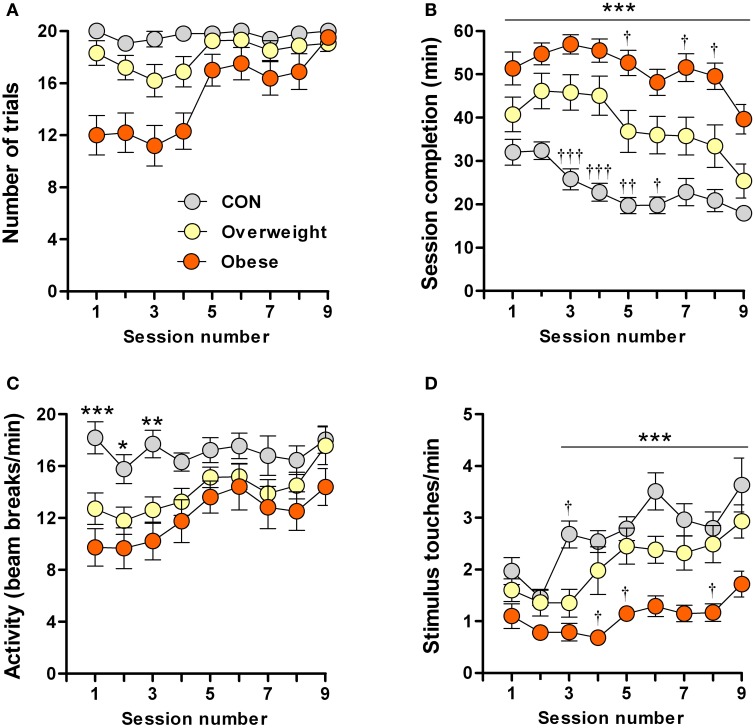
Impaired learning of a food-rewarded operant conditioning task by overweight and obese mice. Control (CON), overweight (O/weight) and obese mice (n = 16/group) were tested in 9 consecutive sessions, each consisting of 20 trials. Data shown are (A) Number of trials completed per test session; (B) Time (min) required to complete each successive session; (C) Locomotor activity (infra-red beam breaks/min) in touchscreen test chamber; (D) Number of stimulus touches/min. Data is presented as means ± s.e.m. *, **, ***Indicate significant differences between CON and obese groups (p < 0.05, 0.01, and 0.001, respectively). †, ††, †††Denote significant differences between overweight mice vs. CON and obese mice (p < 0.05, 0.01, and 0.001, respectively).